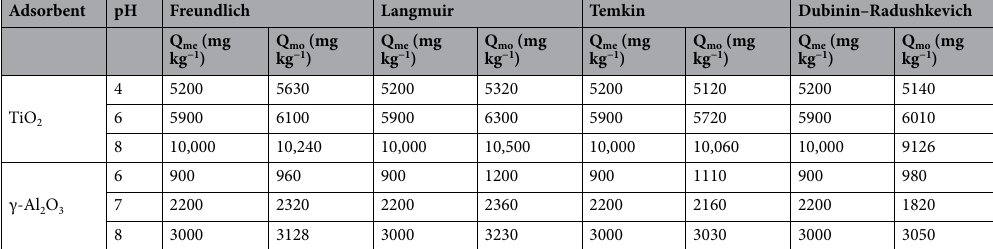
Table 4. Copper adsorption capacity by TiO 2 and γ-Al 2 O 3 nanoparticles at different pH values. Q me and Q mo are the maximum Cu(II) concentration and predicted by various isotherm models